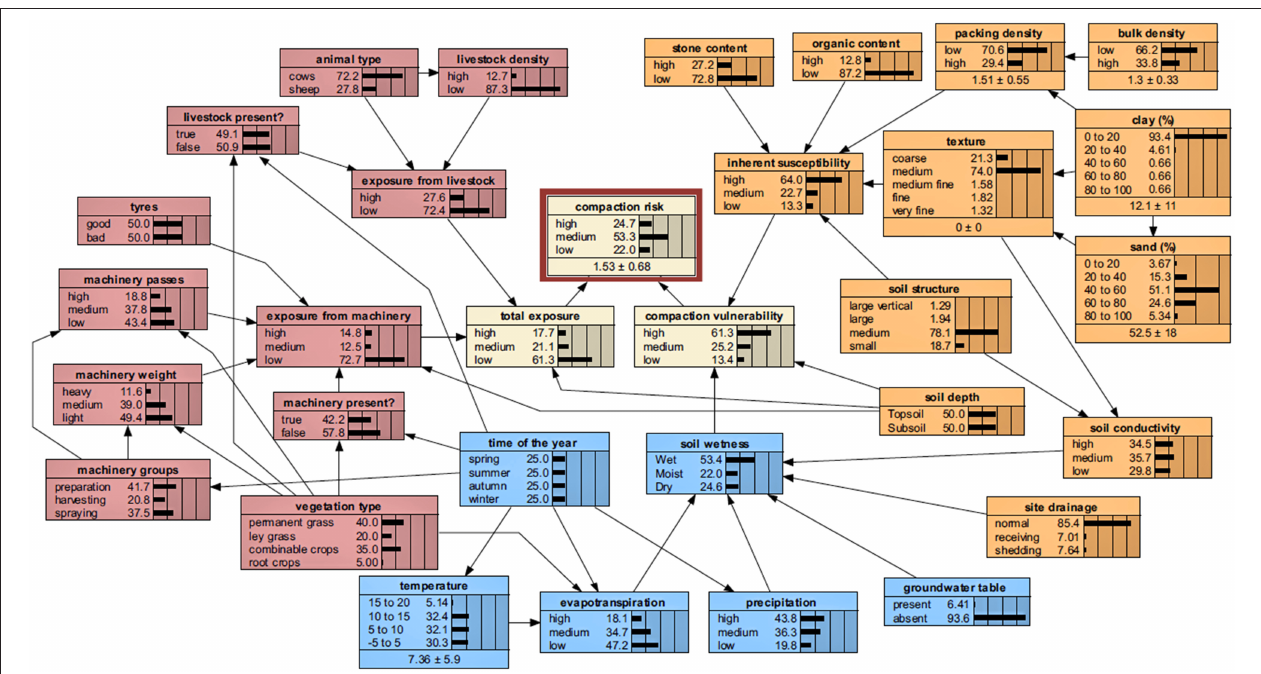
FIGURE 9 | Schematic diagram of Bayesian Belief Network (BBN) corresponding to the assessment of the risk of soil compaction. The numbers in the boxes are the probabilities (%) of state values associated with each node, based on average conditions in Scotland (Modified from Troldborg et al.,